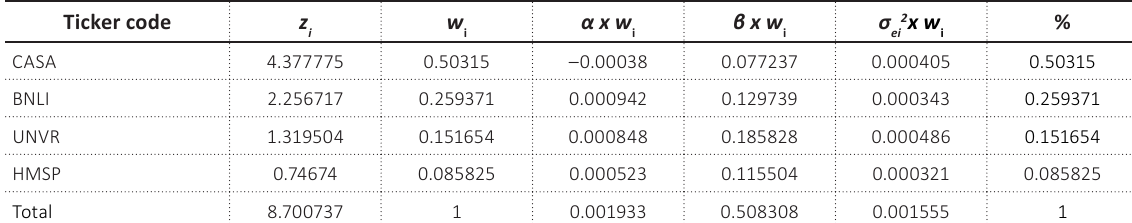
of ERBi and C* values and W i i